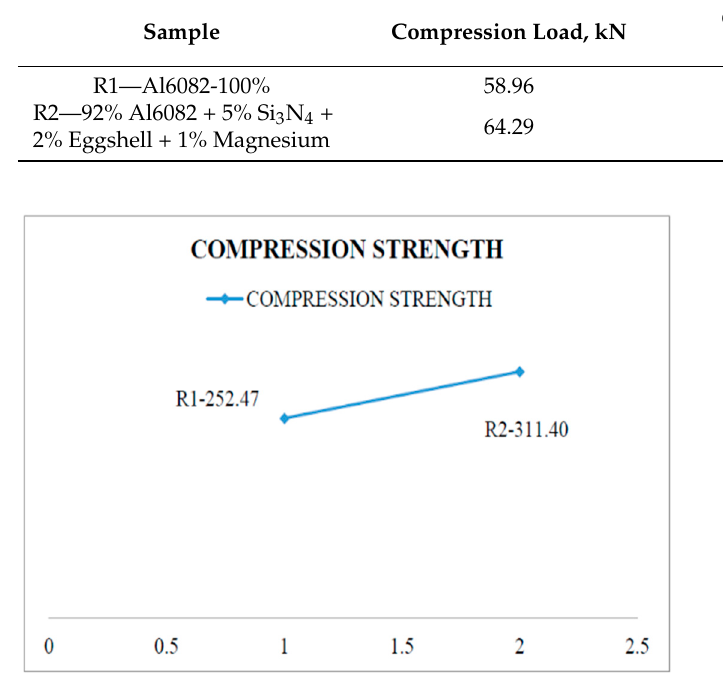
Figure 7. Compression strength graph.